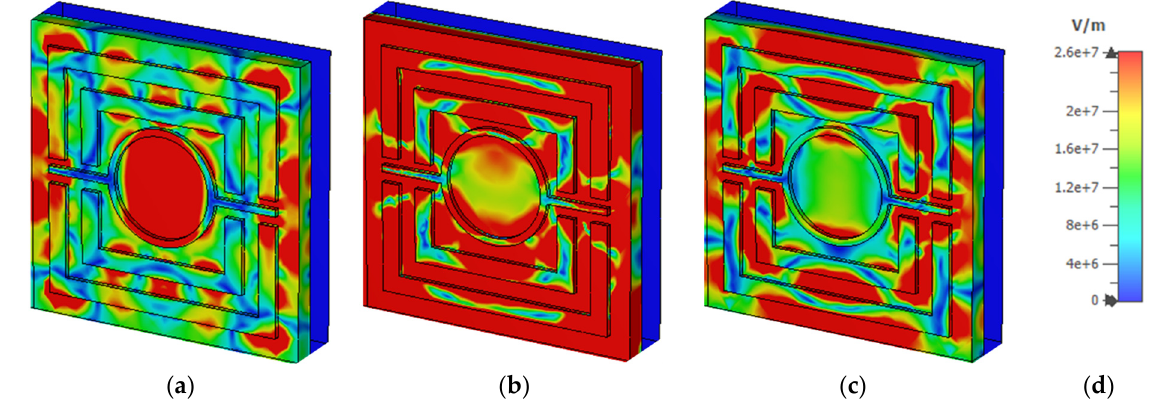
Figure 13. E-field distribution at ( a ) 450 nm ( b ) 557 nm ( c ) 650 nm ( d ) V/m scale.